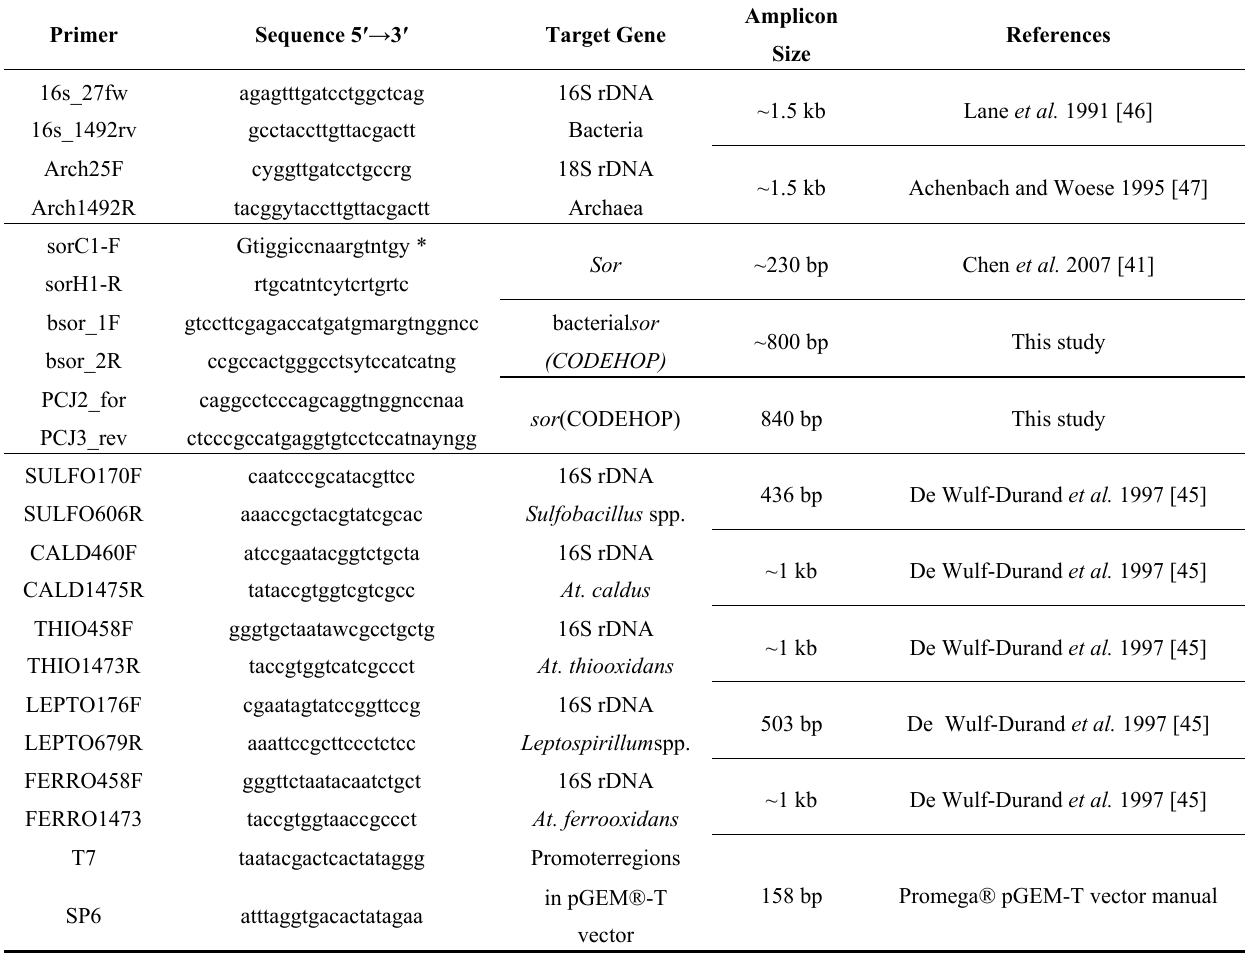
Table 1. Polymerase chain reaction (PCR) primers used in this